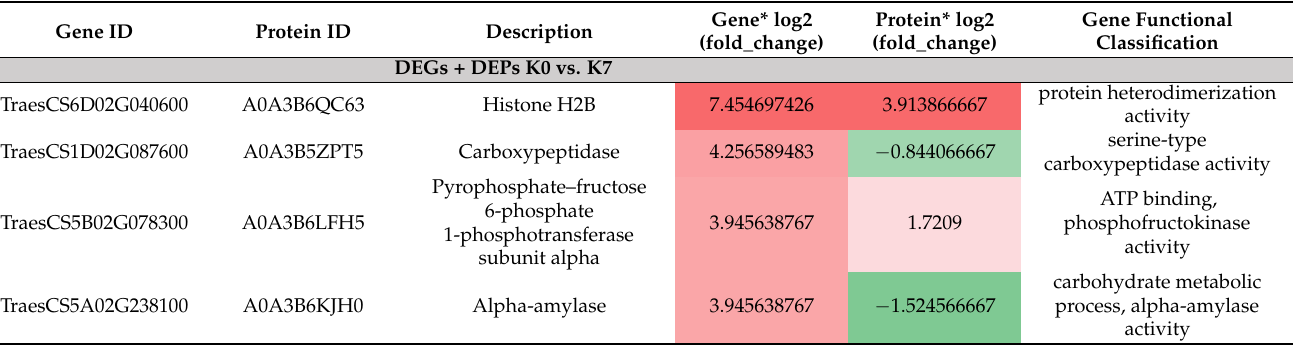
Table 1. A list of genes that can be simultaneously identified in DEGs and DEPs selected for each